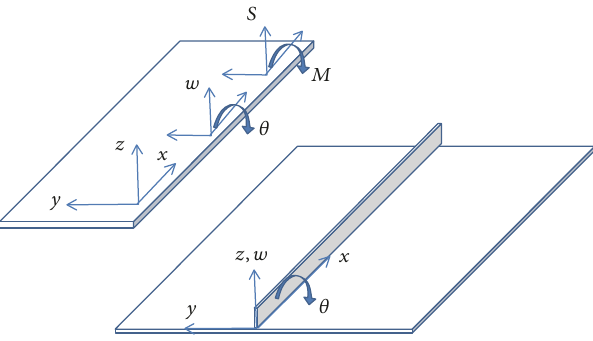
Figure 2: Schematics of the stiffener and plate.